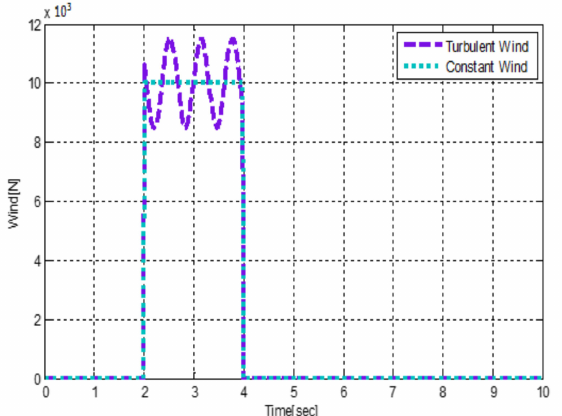
Figure 12. Average and simulated wind